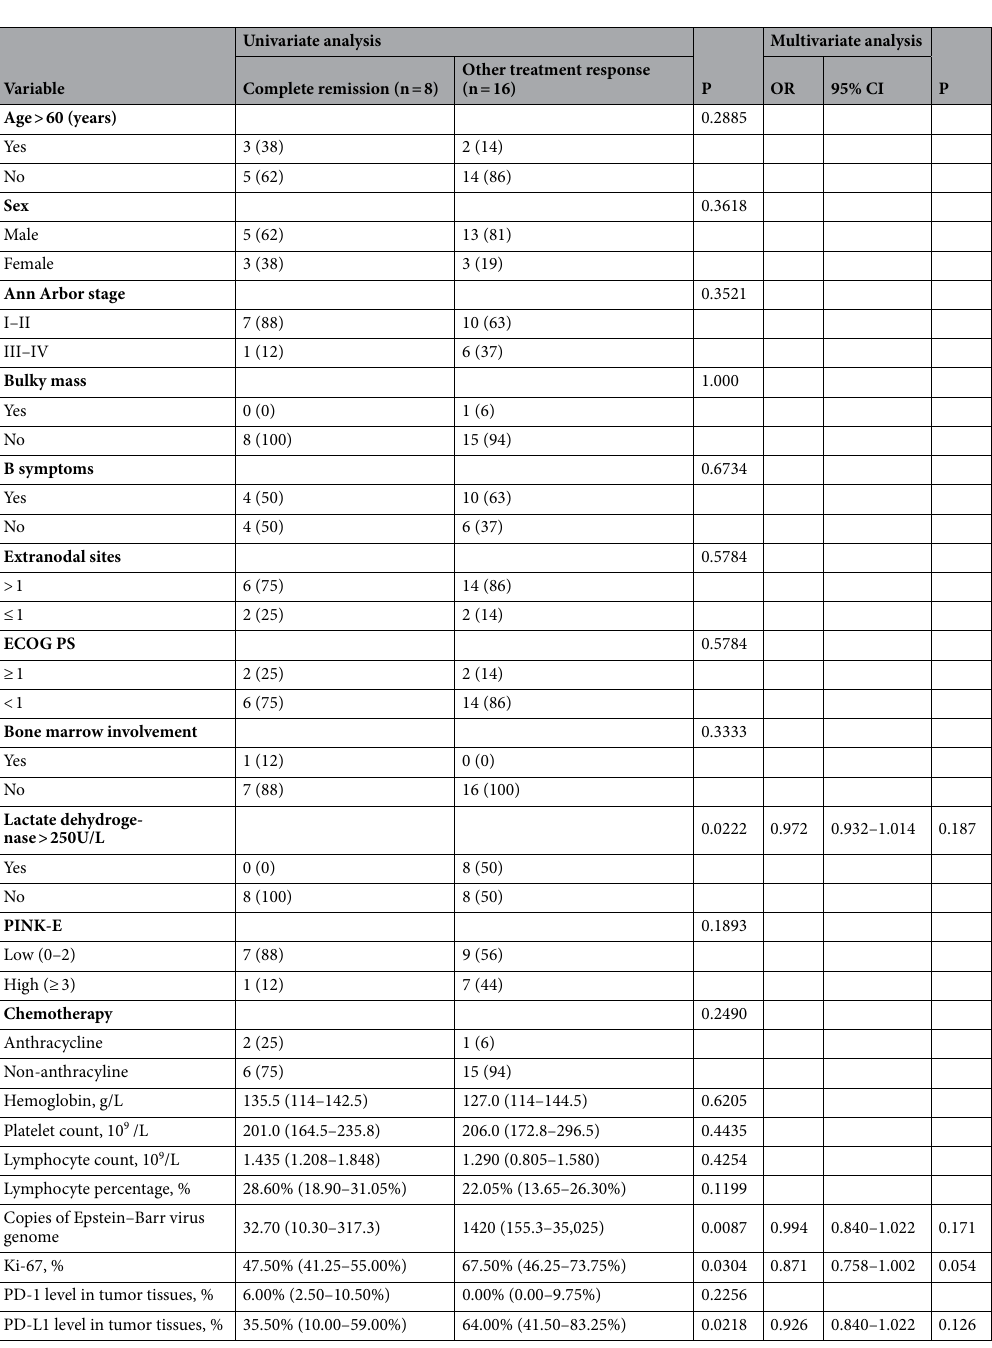
Table 2. Univariate and multivariate analyses to identify predictors of treatment response among ENKTL patients. Values are n (%) or median (interquartile range). ENKTL extranodal natural killer/T-cell lymphoma, ECOG PS Eastern Cooperative Oncology Group performance score, PINK-E Prognostic Index of extranodal natural killer/T-cell lymphoma, OR odd ratio, 95% CI ,